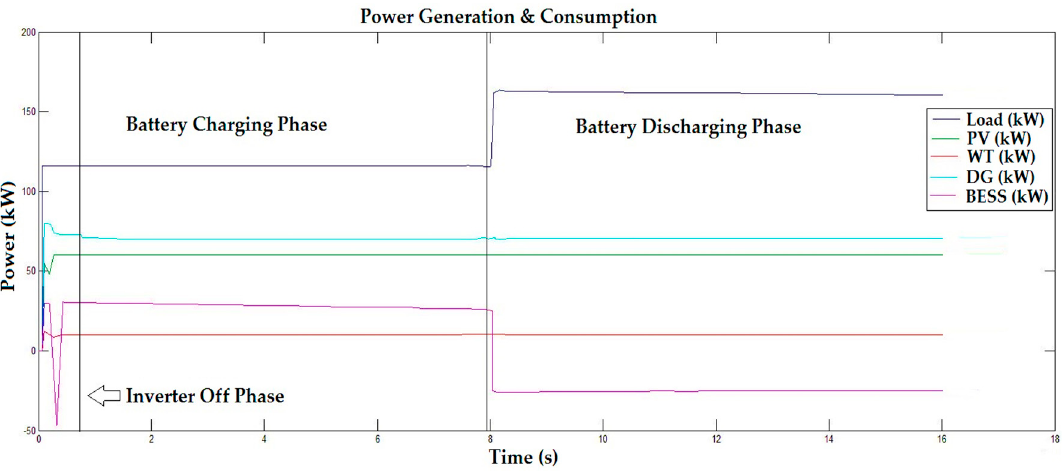
Figure 12 . System output characteristics in battery charging and discharging mode.